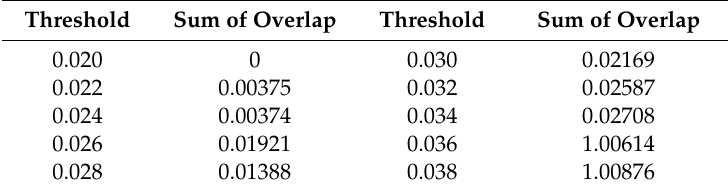
Table 2. Sum of overlap of pulse count feature with different thresholds.